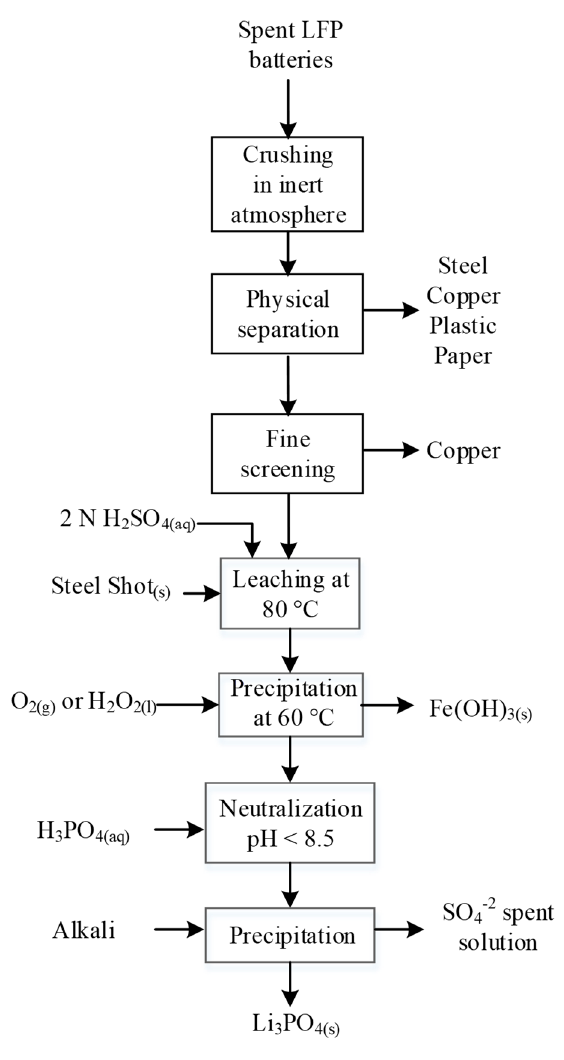
Figure 8. H 2 SO 4 recycling process of lithium-iron phosphate (LFP) batteries patented by Recupyl (according to Ref. [46]).